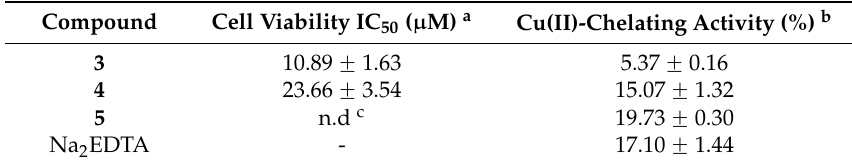
a Concentration of compound resulting in 50% inhibition of cell viability after 24 h treatment. The values are mean ± SD of at least two independent experiments. b Chelating activity observed at 20 µM